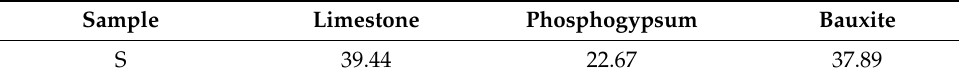
Table 2. Proportioning of the cement raw meal (wt %).